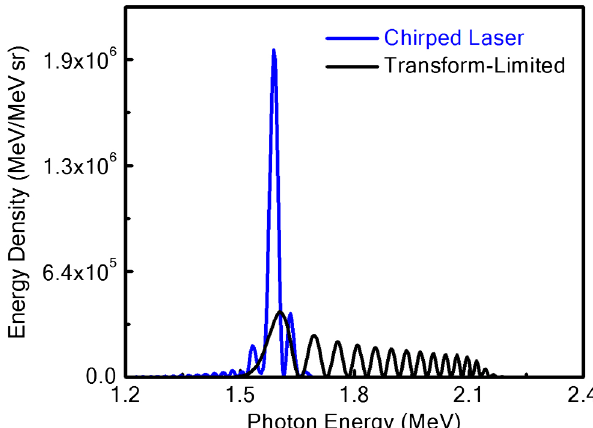
FIG. 6. On-axis radiated energy density from the scattering of a 300-MeV electron by a 90-fs FWHM and 1 : 6 (cid:3) 10 18 - W = cm 2 - peak-intensity chirped laser pulse (blue line) and transform- limited pulse (black line). The photon flux per unit solid angle is approximately 4 : 1 (cid:3) 10 4 photons = sr and 4 : 3 (cid:3) 10 4 photons = sr for scattering with the chirped and transform-limited laser pulses,